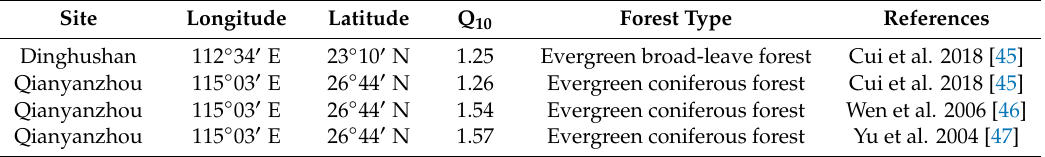
Table 5. Q 10 values of ecosystem respiration from eddy covariance measurements in subtropical forests in the